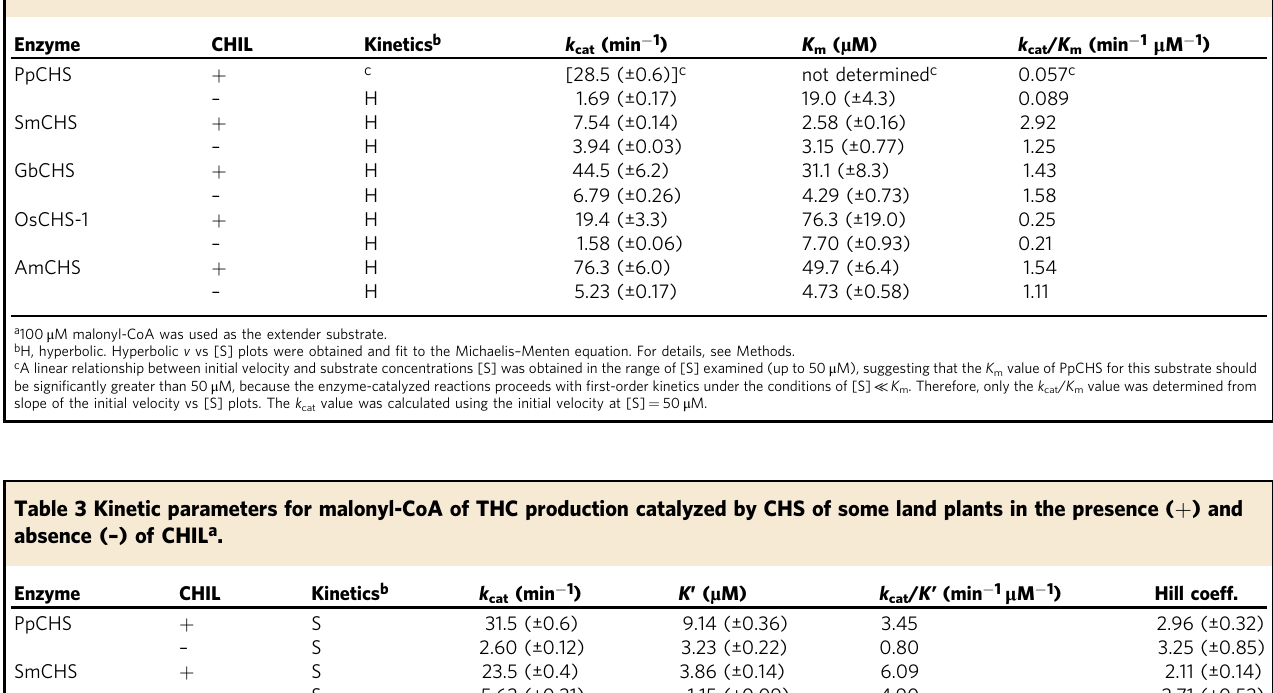
Table 2 Kinetic parameters for p -coumaroyl-CoA of THC production catalyzed by CHS of some land plants in the presence ( + ) and absence ( – ) of CHIL a .